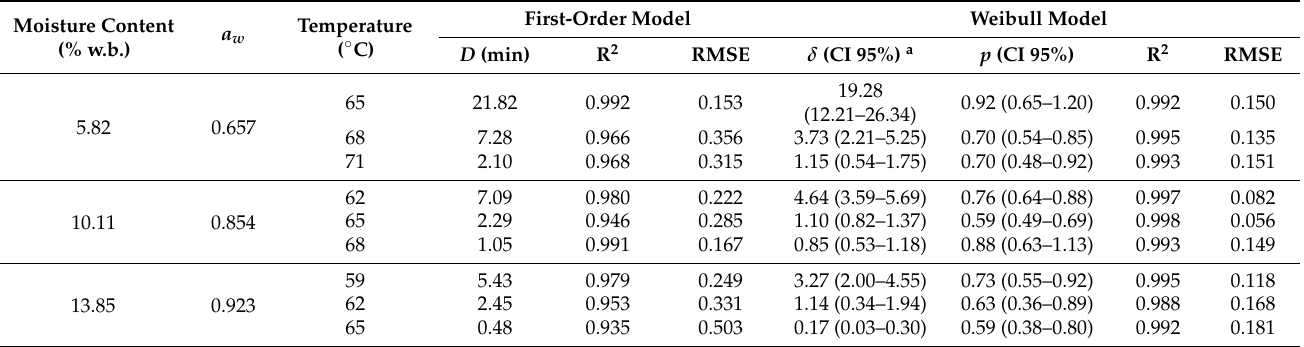
Table 2. D -, δ - and p -values of the two models for the target Aspergillus in almond kernel flour at three a w and temperature levels using test